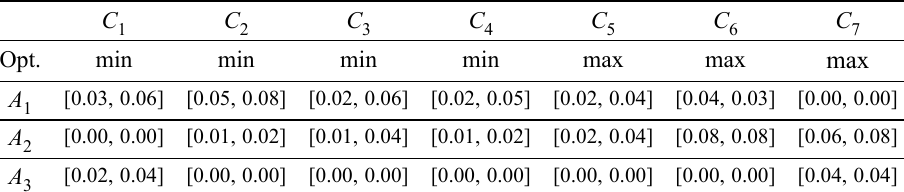
Table 9. Weighted normalized grey decision